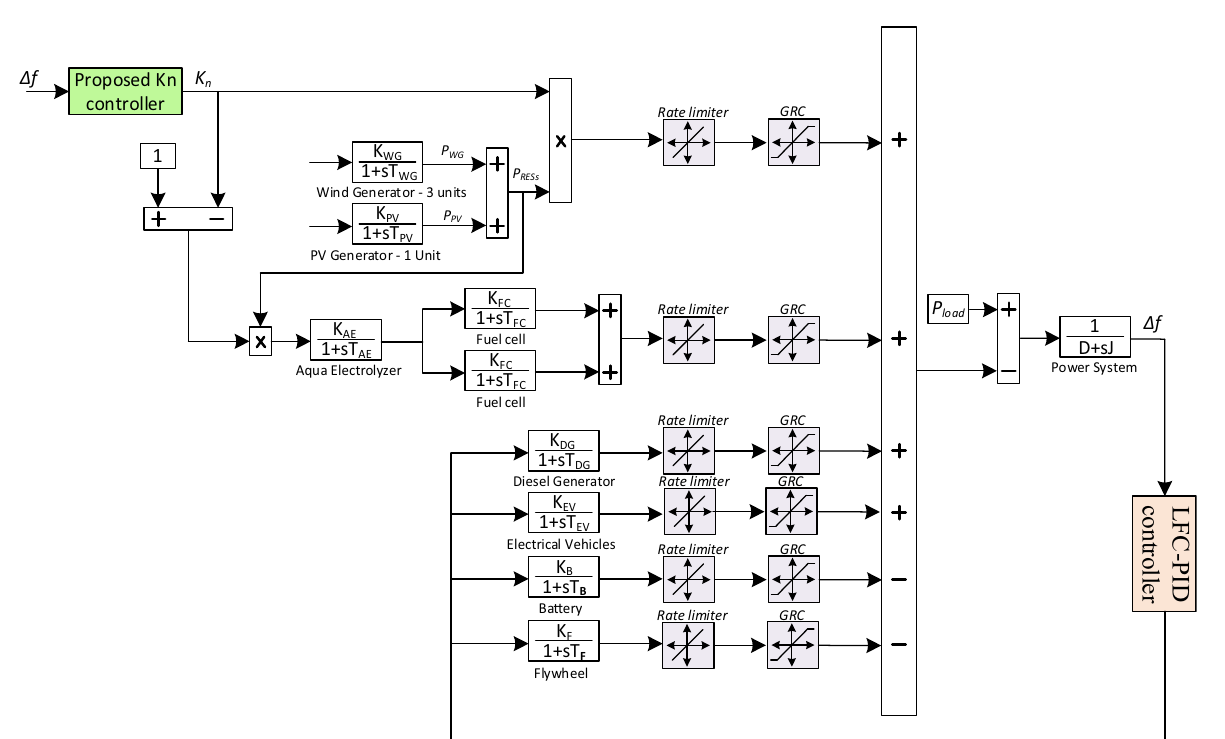
Fig. 1 The studied HGS with the proposed coordination control strategy